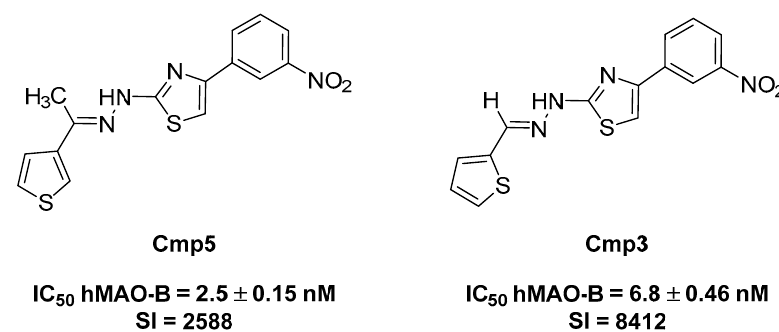
Figure 1. Structures and monoamine oxidase (MAO) inhibitory activity of the tested